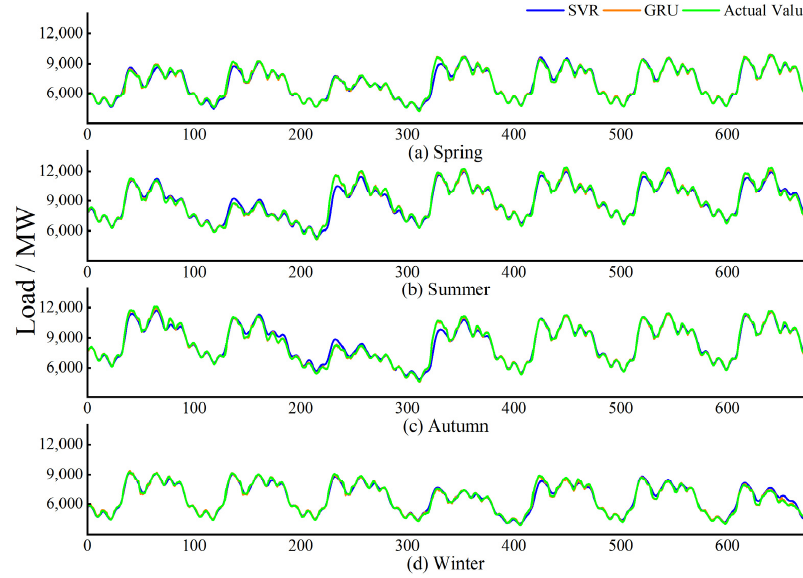
Energies 2023 , 16 , x FOR PEER REVIEW Figure 6. Point forecasting results of dataset A. Figure 6. Point forecasting results of dataset A.